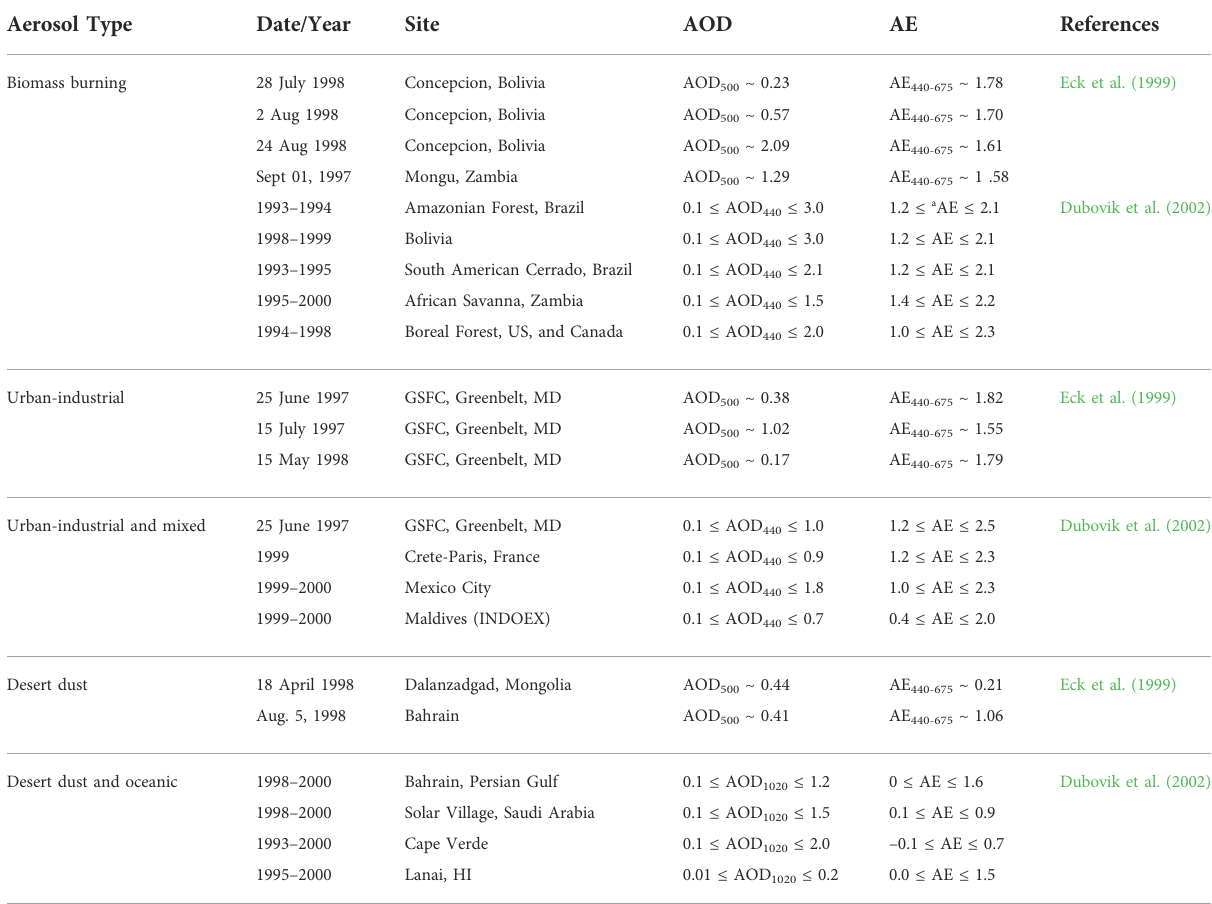
TABLE 1 AOD and AE for aerosol types retrieved from AERONET by SEA